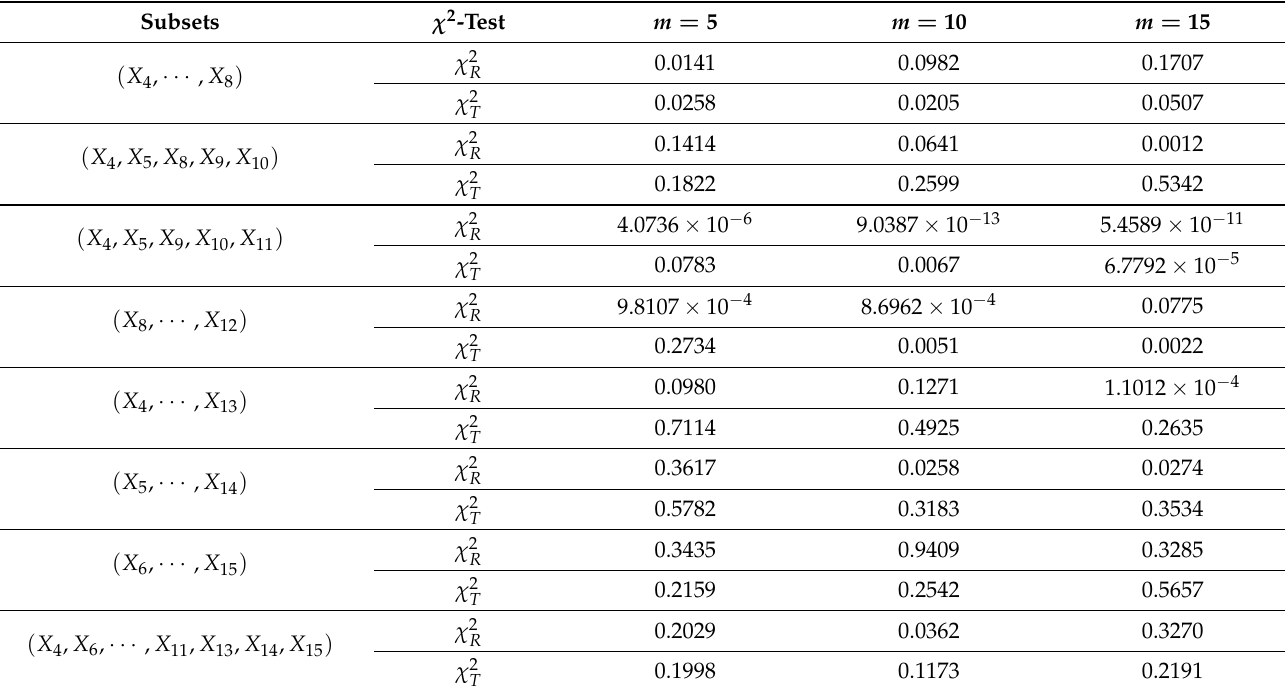
Table 4. p -values from the two chi-square tests (data: